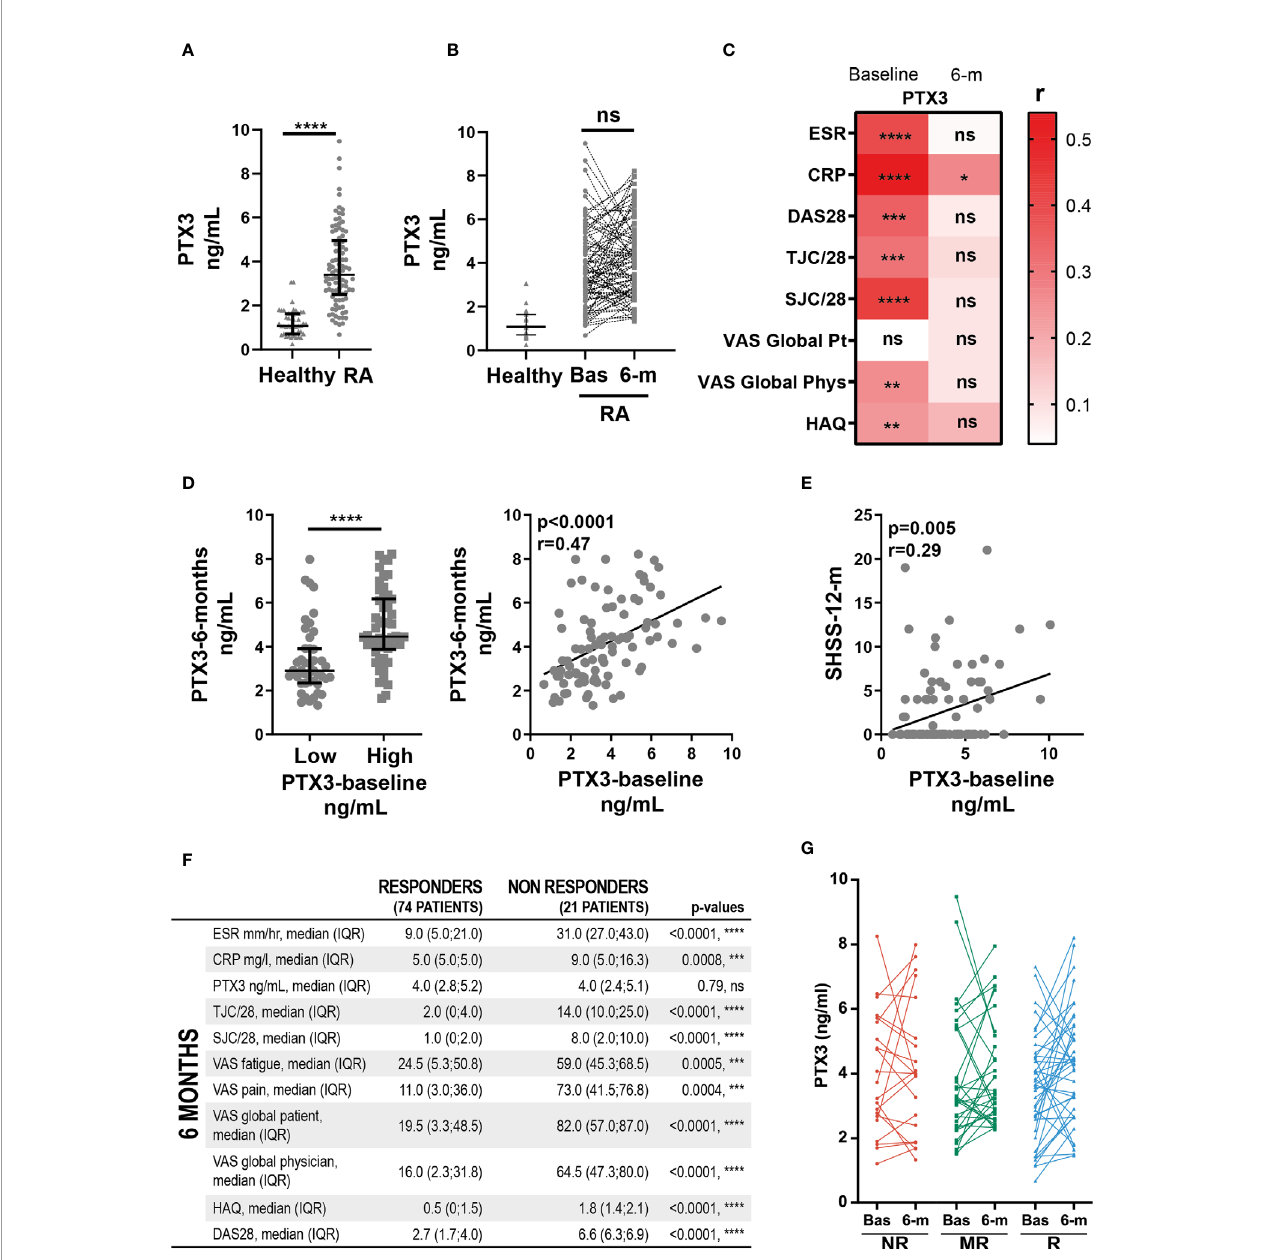
FIGURE 1 | Levels of circulating PTX3 correlate with disease severity in early untreated RA patients, but not with clinical response to cs-DMARDs treatment. (A) PTX3 serum levels in patients with early treatment-naïve RA (n=119) and age- and gender-matched healthy donors (n=43). ****p < 0.0001, as assessed by parametric unpaired t-test. (B) PTX3 serum levels in healthy donors (n=43) and in paired patients at baseline (Bas) (n=119) and at 6-months (n = 95). ns, non- signi fi cant, as assessed by the parametric paired t-test comparing RA baseline and 6-months samples. (C) Left panel, PTX3 serum levels at 6-months in patients presenting a low ( ≤ 3.23 ng/mL) or high (>3.23 ng/mL) PTX3 serum levels at baseline, ****p < 0.0001 assessed by the parametric unpaired t-test. Right panel, correlation between PTX3 serum levels at baseline and at 6-months, p-value and r coef fi cient were calculated according to the Pearson correlation test. (D) Heatmap representing the correlation between PTX3 serum levels at baseline or 6-months (6-m) after cs-DMARDs treatment with clinical parameters: erythrocyte sedimentation rate (ESR), C-Reactive Protein (CRP), Disease Activity Score 28 (DAS28), Tender and swollen joint counts (TJC/28, SJC/28), patient (Pt) and physician (Phys) global health assessment by Visual Analogue Scale (VAS) and Health Assessment Questionnaire (HAQ). The red scale represents the spearman r coef fi cient. *p < 0.05, **p < 0.01, ***p < 0.001, ****p < 0.0001, as assessed by the Pearson correlation test. (E) Correlation between PTX3 serum levels at baseline and the van der Heijde modi fi ed Sharp score (SHSS) assessed at 12-months, p-value and r coef fi cient were calculated according to the Pearson correlation test. (F) Table presenting the clinical characteristics of responders (good and moderate) and non-responders patients to cs-DMARD treatments at 6-months, according to EULAR criteria. (G) PTX3 serum levels at baseline (Bas) or at 6-months (6-m) in non-responders (NR, red lines), moderate responders (MR, green lines) and good responders (R, blue lines) patients to cs-DMARD treatments. ( A – C Left panel) Data are represented as median +/- interquartile